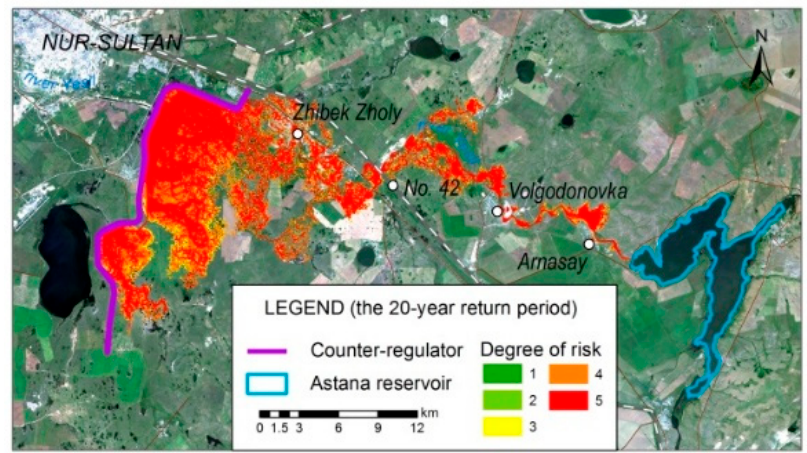
Figure 10. Hazard map (Classification 2) produced from the 100-year return period flow hydrograph.